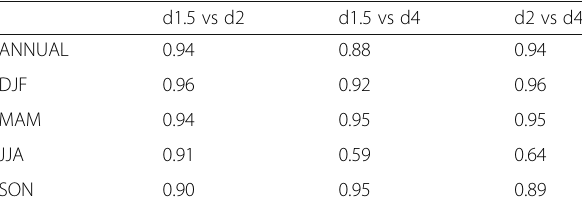
Table 3 Pattern correlation coefficients of future changes in precipitation amounts